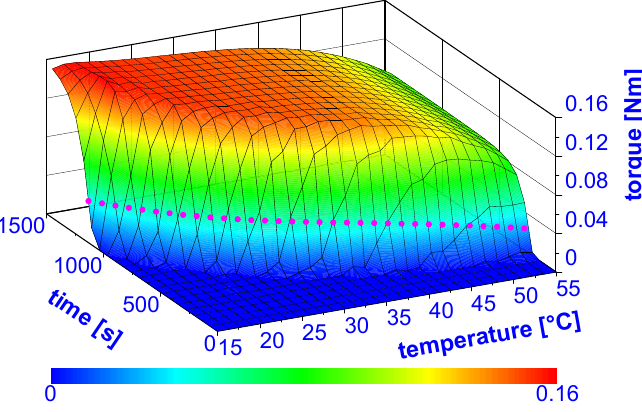
Figure 5. Approximation model for curing behavior of adhesive SikaFast 5215